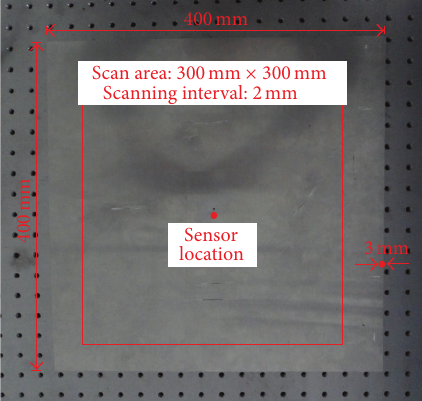
Figure 3: An aluminum plate and scanning